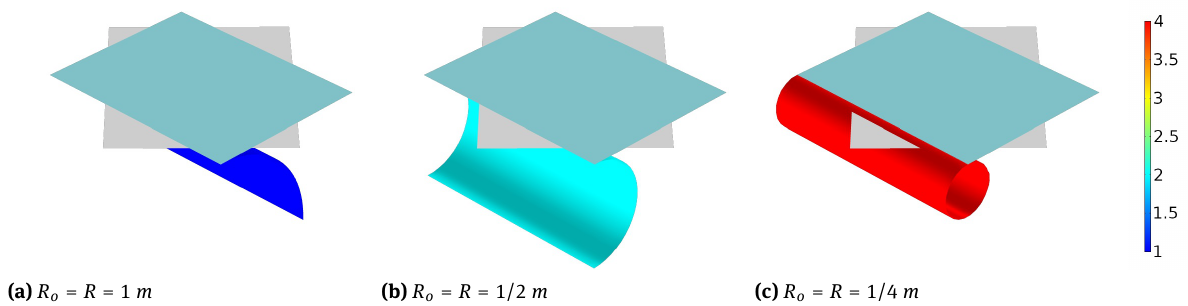
Figure 3: Bending of a flat shell obtained by a change of the target metric B o . Each of the three plots shows the computational domain (gray), the reference surface (cyan), and the actual shape (color map of curvature). Each deformed configuration is